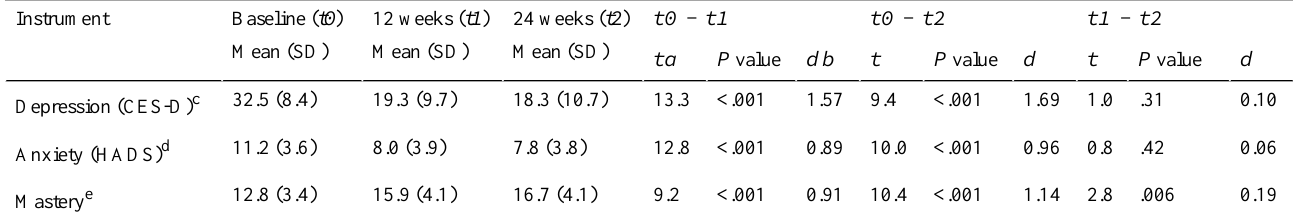
Table 6. Effect maintenance in the Master Your Mood group (n =